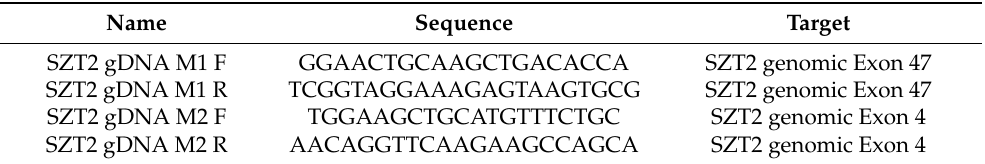
Table 2. Primers used for PCR and